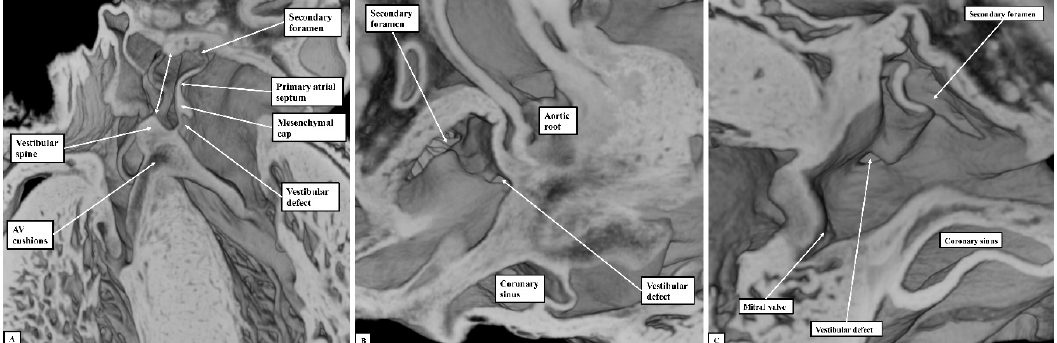
Figure 7. The images show the features of the vestibular defect, as was found in four of the datasets. The dataset used to prepare the figure is sectioned so as to show the appearance of the defect in the four-chamber plane (Panel A ), and as seen from the right (Panel B ) and left (Panel C ) sides. The double-headed white arrow in the left-hand panel shows the margins of the oval fossa. AV— Atrioventricular.